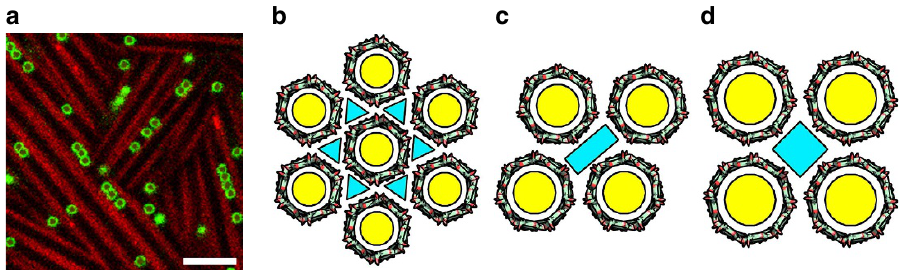
Figure 5 | Applications of the lattice self-assembly of SDS@2 b -CD. ( a ) A confocal laser scanning microscopy image of monodisperse 800nm liposomes inside the tubes, scale bar, 4 m m. ( b – d ) Schematic representations of the CD networks formed after guest removal. Hexagonal ( b ), rhombic ( c ) and square ( d ) lattices of a -CD, b -CD and g -CD, respectively. The cyan and yellow regions indicate hydrophilic and hydrophobic pores,